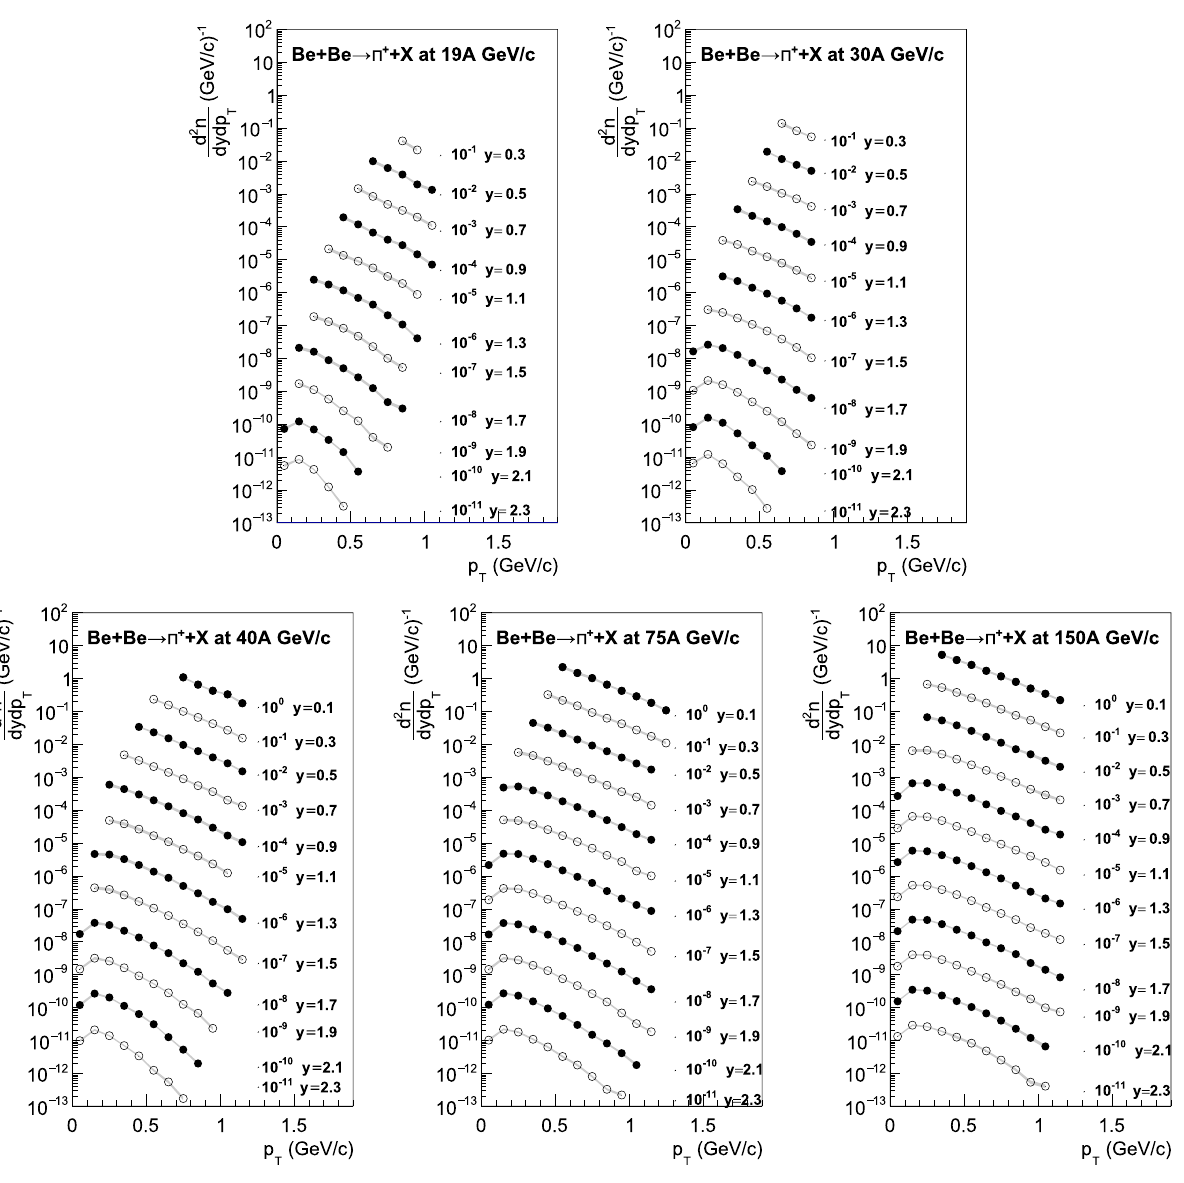
Fig. 22 Transverse momentum spectra in rapidity slices of π + pro- duced in the 20% most central Be+Be collisions. Rapidity values given in the legends correspond to the middle of the corresponding inter-